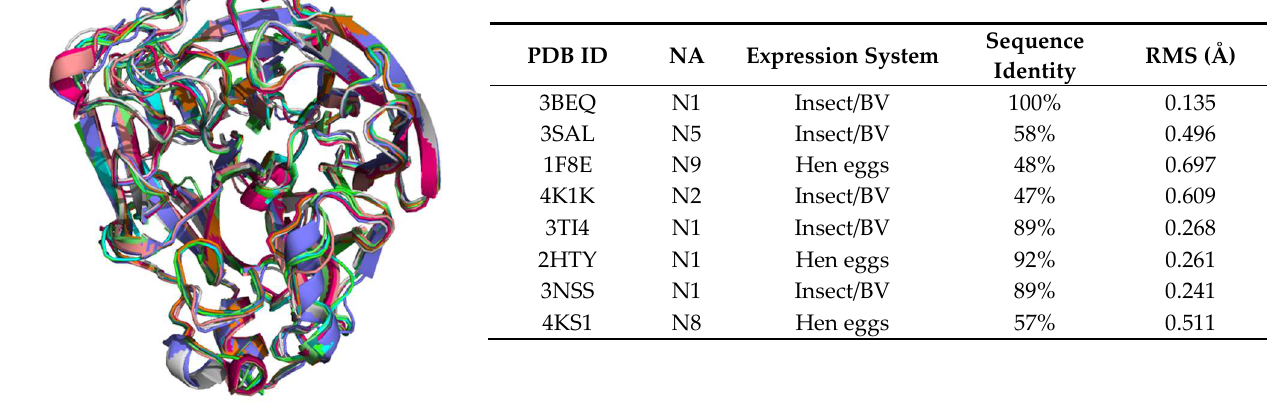
Figure 7. The H1N1 NA tetramer structure from HEK cell produced protein. The NA tetramer is made up of four mono- mers each related by a non-crystallographic four-fold axis of symmetry. The top left monomer is shown as a protein